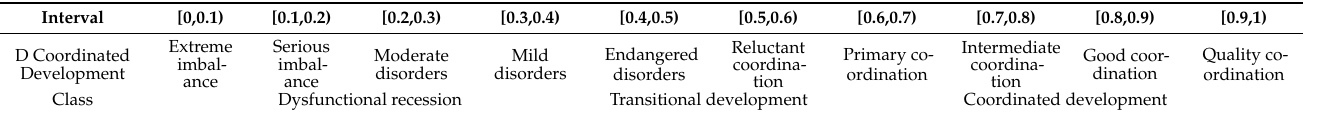
Table 7. Criteria for the division of coordination grades and coordinated development